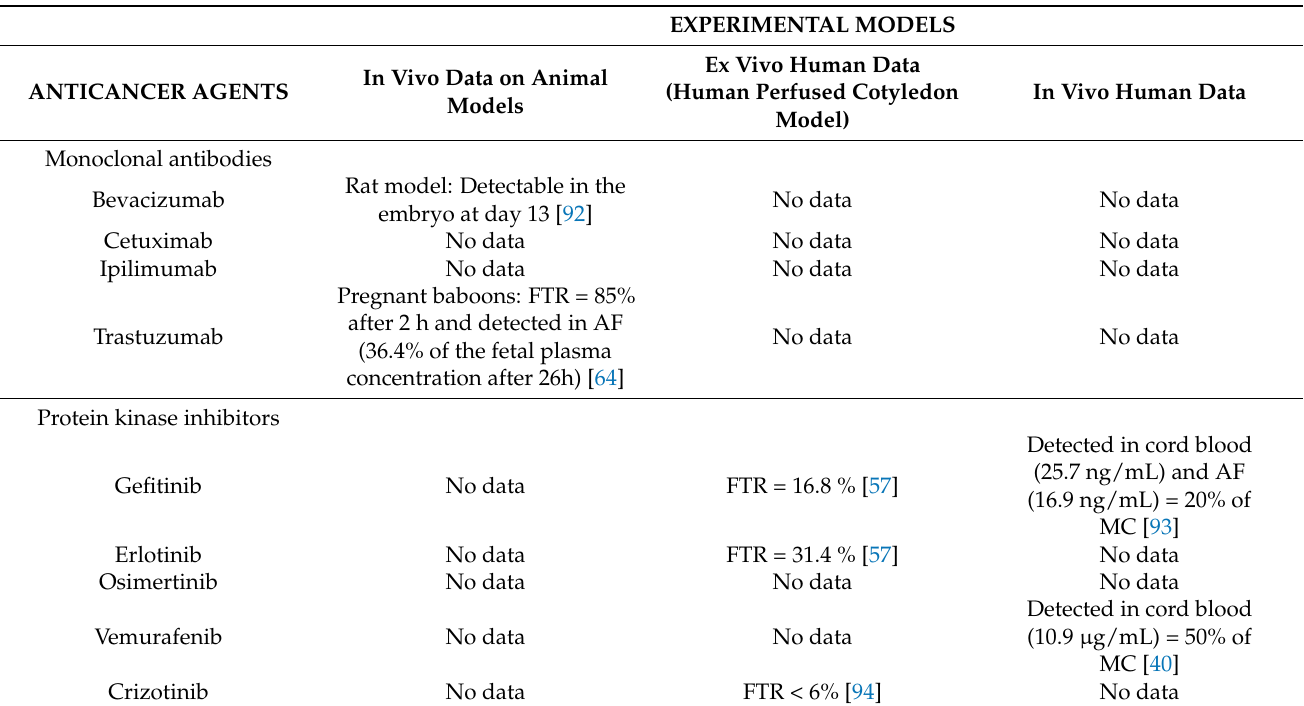
Table 1. Cont . EXPERIMENTAL